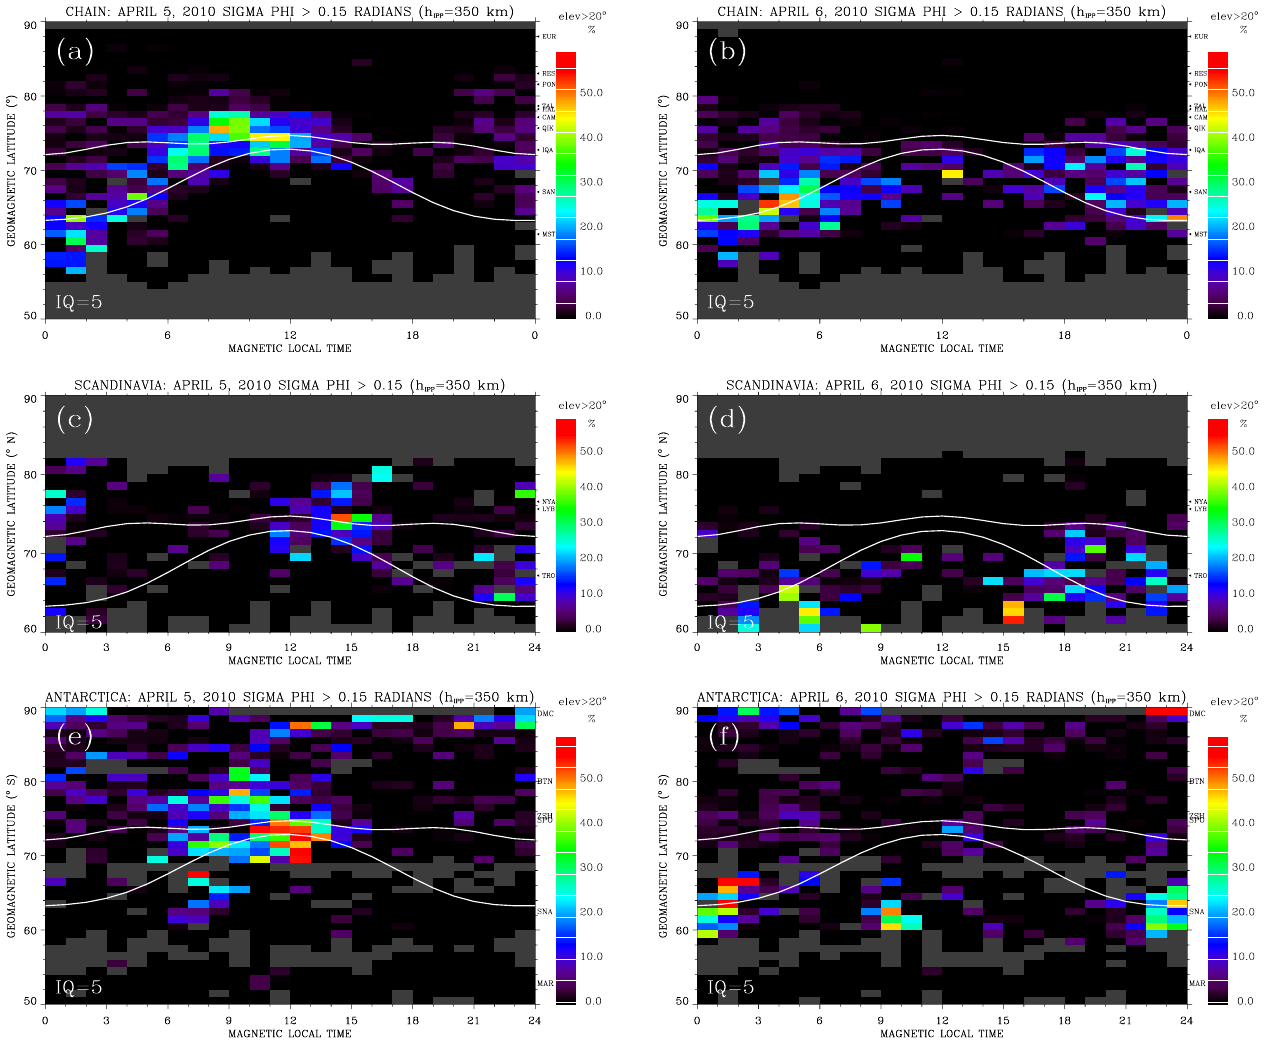
Fig. 9. Phase scintillation occurrence as a function of MLT and CGM latitude for (a) – (b) CHAIN, (c) – (d) North European and (e) – (f) Antarc- tic arrays for 5 and 6 April. Superposed in white line is the Feldstein statistical auroral oval for